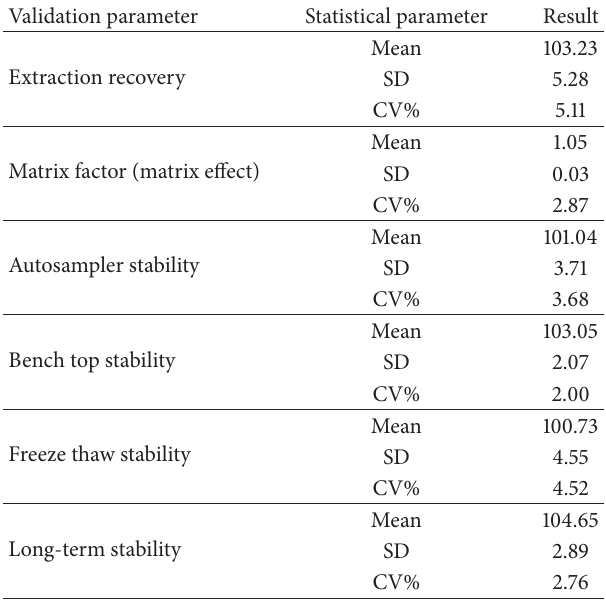
Table 3: Summary of validation parameters for CrEL-PEG in rat